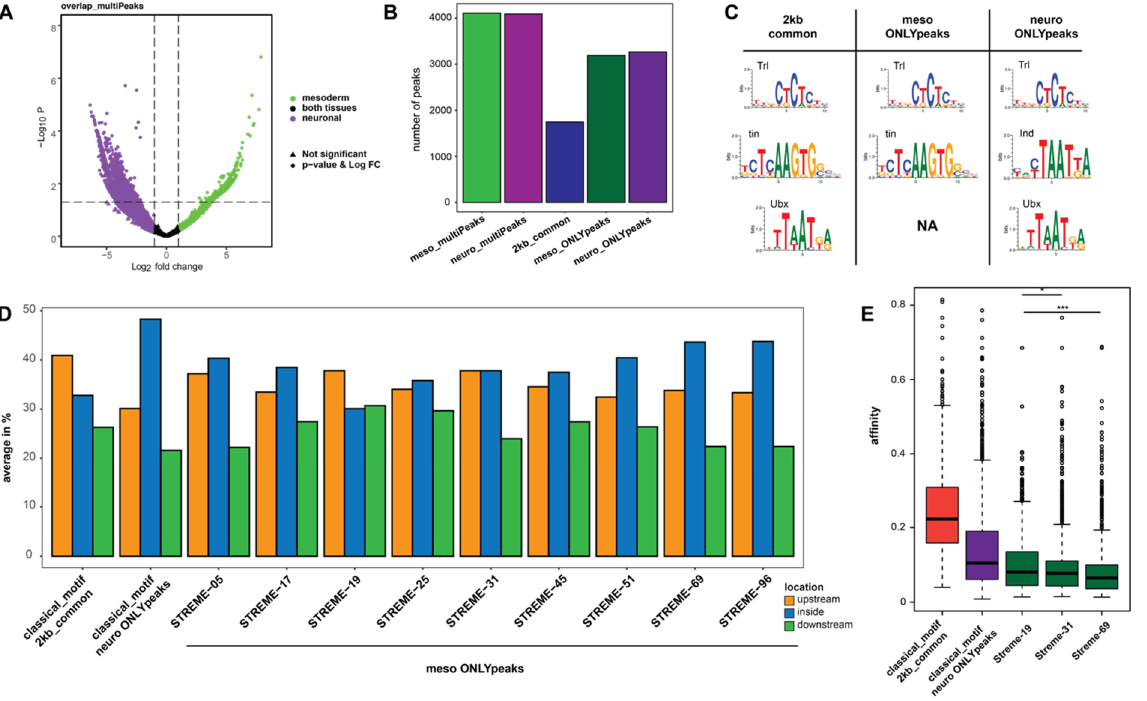
Figure 3. Mesodermal and neuronal Ubx chromatin interactions are different. ( A ) Volcano plot of the selected DiffBind results, the plot shows the distribution of common genes that contain multiPeaks in a tissue-specific manner. ( B ) Bar plot representing the number of peaks tissue specifically associated from the DiffBind analysis used for sub-division in three categories: 2kb_common (mesodermal and neuronal peaks are not as far away as 2 kb and combined in one group), meso_ONLYpeaks, neuro_ONLYpeaks. ( C ) Motif search based on an Analysis of Motif Enrichment (AME within the MEME suit) using the sequences from three categories. The classical Ubx motif is not found in meso_ONLYpeaks. NA: not available. ( D ) Bar plot showing the distribution of classical and novel motifs, which were identified using the Sensitive, Thorough, Rapid, Enriched Motif Elicitation method (STREME) within the MEME suit, in the 2kb_common, neuro_ON- LYpeaks, meso_ONLYpeaks category. The plot displays a variance of motif location in meso_ONLYpeaks data set. ( E ) Predicted Ubx binding affinities to selected genomic regions. The classical Hox motif in 2kb_common and neuro_ON- LYpeaks, as well as selected motifs for the meso_ONLYpeaks data set. The classical motifs show a high affinity, whereas the selected motifs in the meso_ONLY data set have a low affinity. The analysis used model 6: Selex data for Ubx isoform Ia.